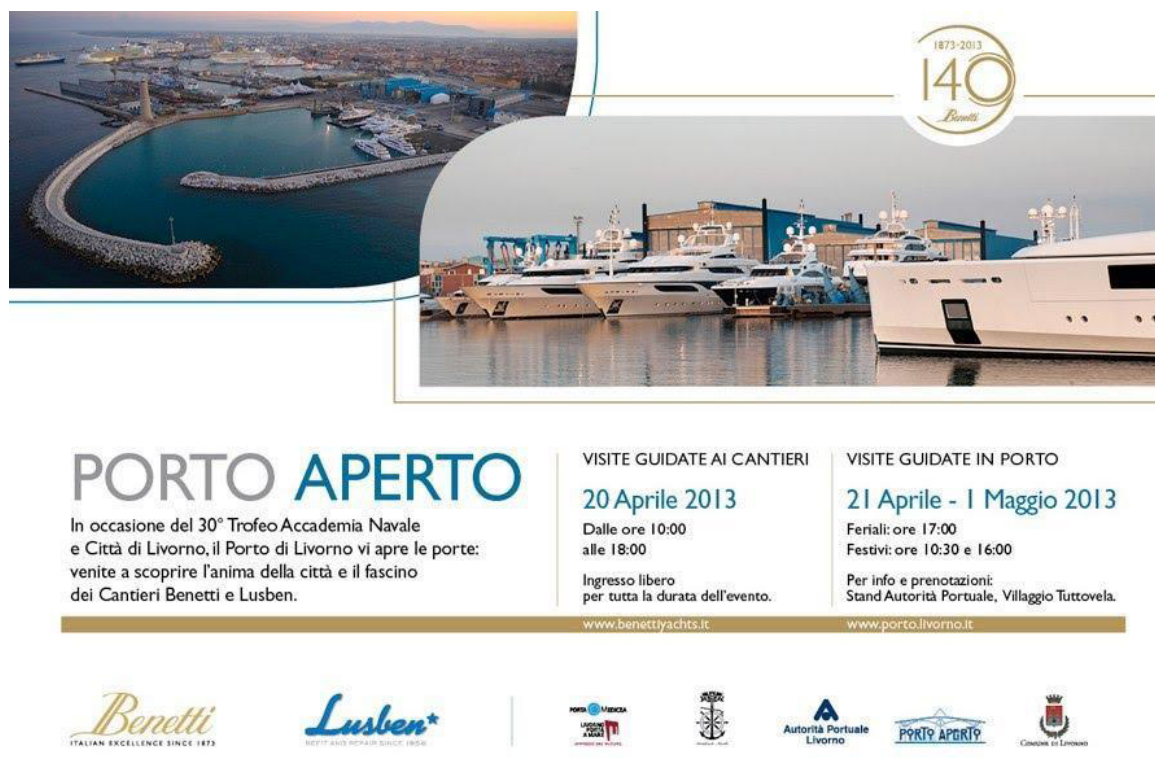
FIG. 3 The “Open Port” Programme at the “Sea Gate” - (Graphic material produced by the North Tyrrhenian Port Network